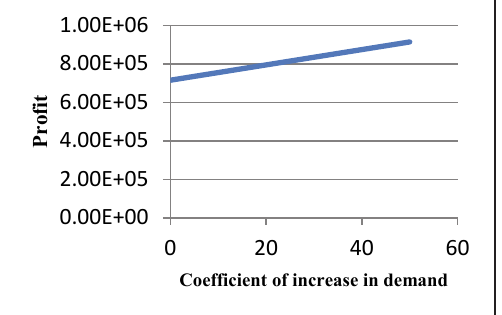
Fig. 3. The analysis of increasing the demand of retailers on environmental objective